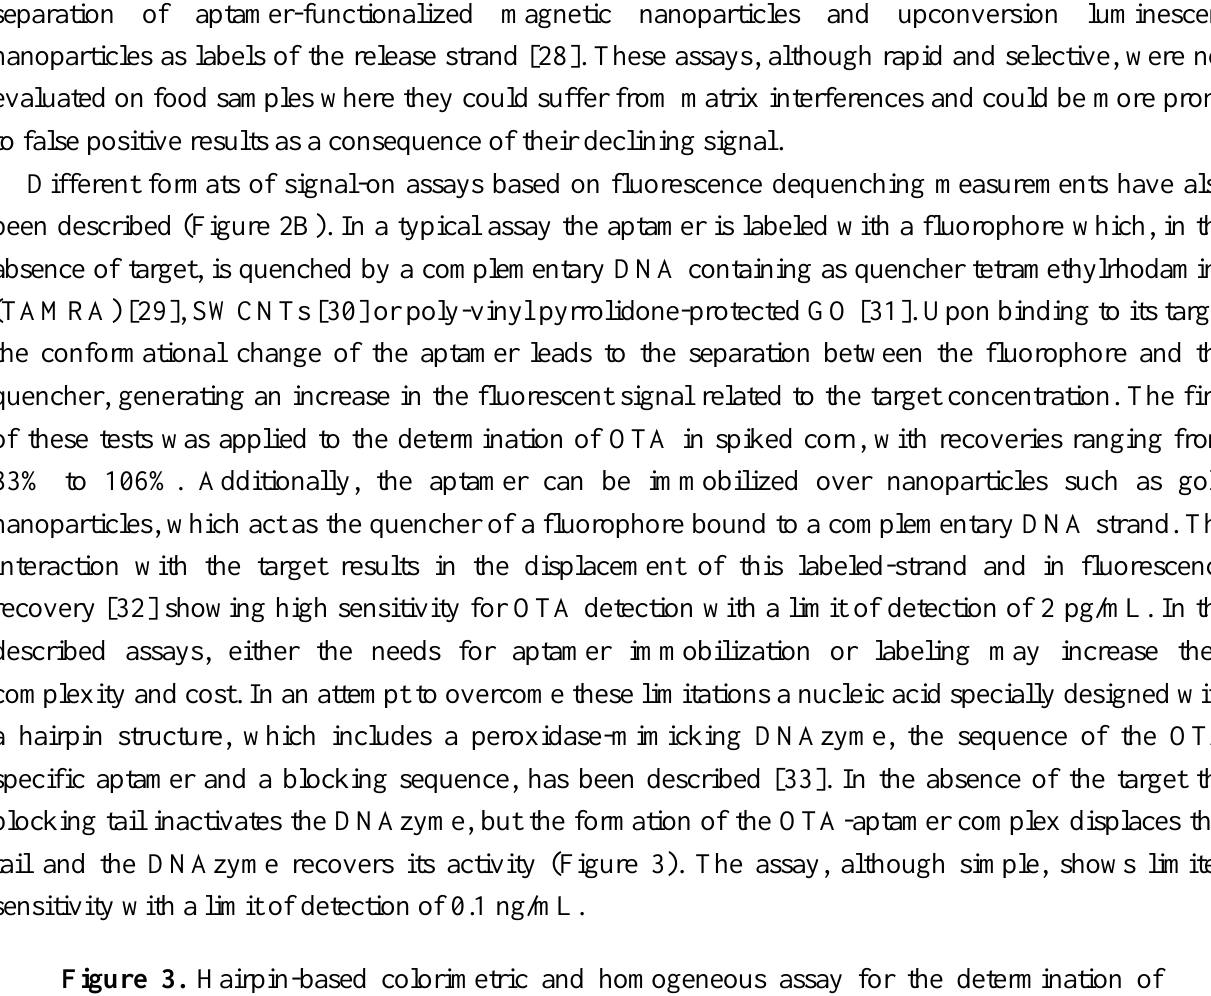
Figure 3. Hairpin-based colorimetric and homogeneous assay for the determination of OTA (adapted from